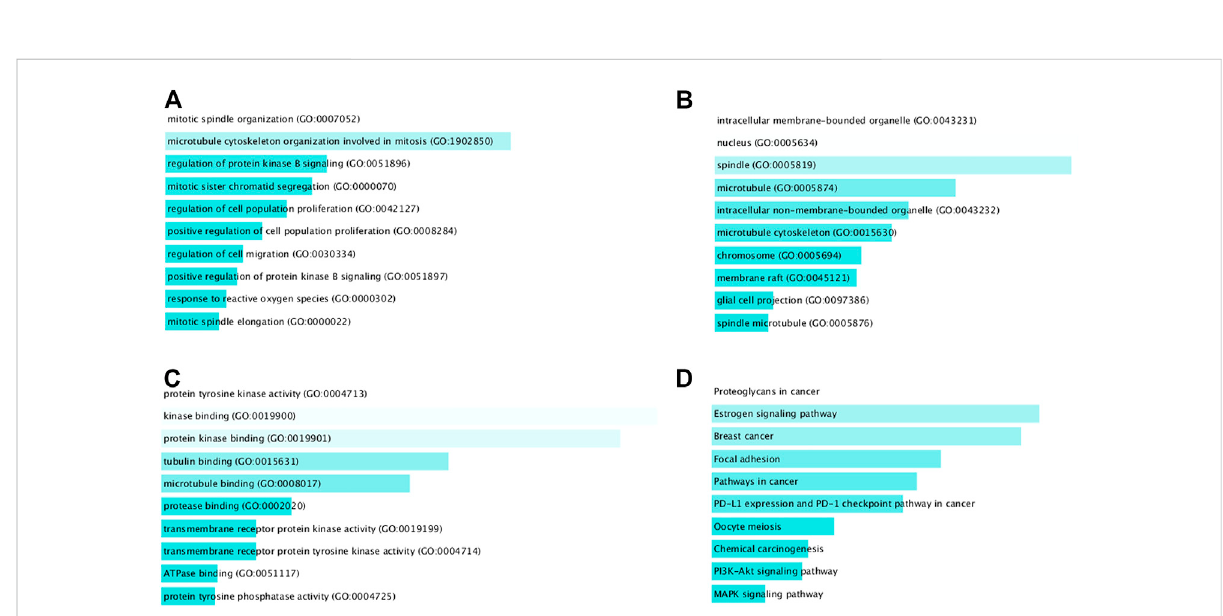
FIGURE 6 Top 10 signi fi cantly enriched terms for each category of DEGs. (A) GO BP-terms, (B) GO CC-terms, (C) GO MF-terms, and (D) KEGG